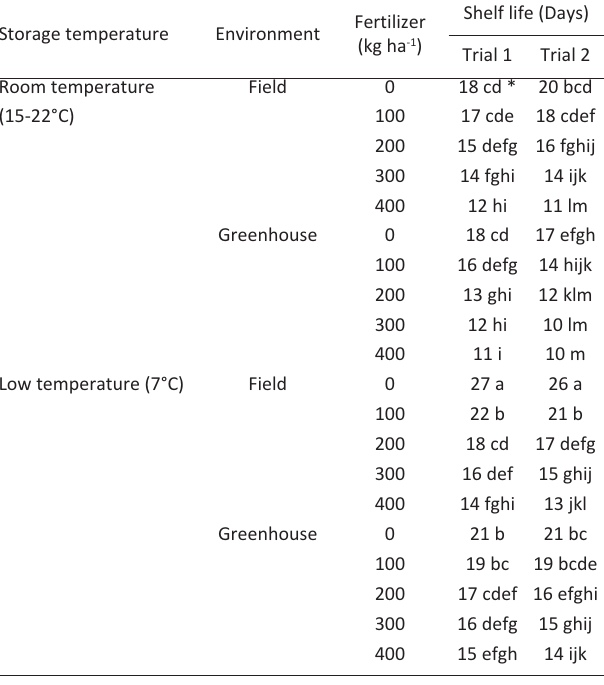
* Means followed by the same letters are not significantly diffe­ rent according to Tukey’s Honestly Significant Difference Test at p≤0.05. Room storage temperature varied between 15 and 22°C. Low temperature was